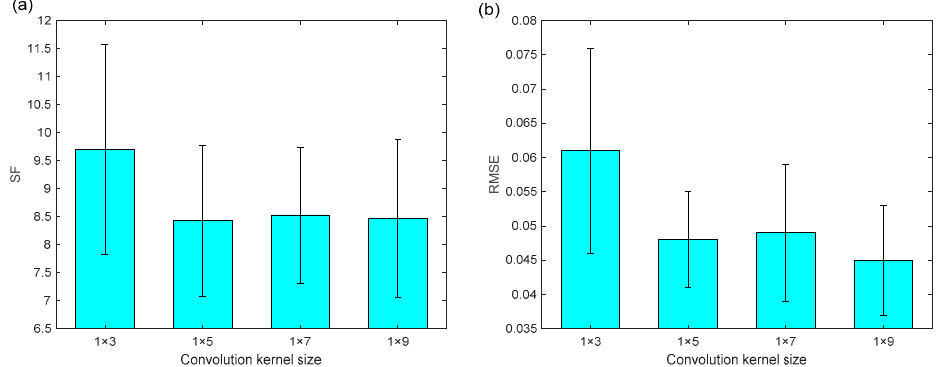
Figure 11. Evaluation indexes based on different convolution kernel sizes: ( a ) RMSE and ( b ) SF.